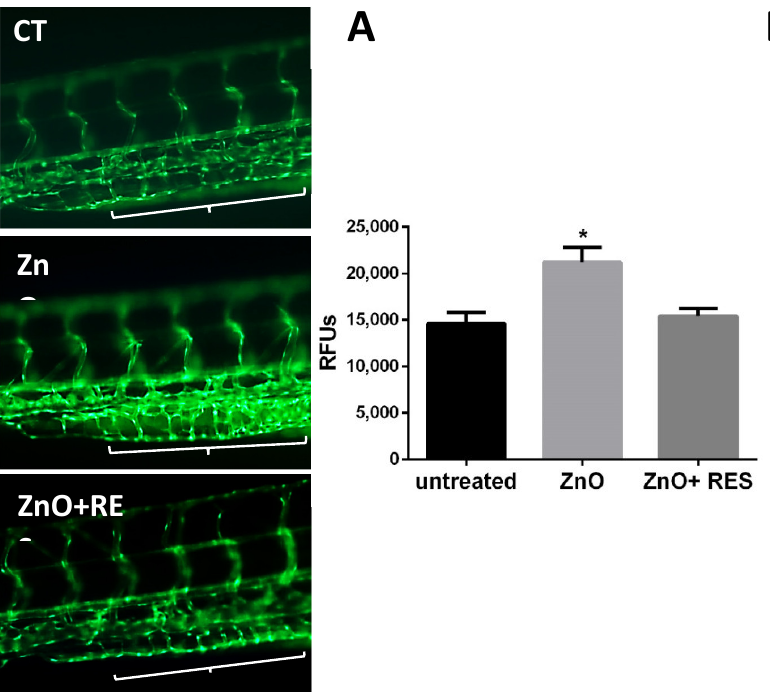
Figure 10. Resveratrol decreases the thickness of the blood vessel in ZnO NP-treated embryos. ( A ) Vessel of caudal vein plexus region of 96-hpf Fli1 embryos treated with 3 mg/L ZnO NP (ZnO) showed a significant increase in green fluorescence intensity (Thickening) compare to the untreated group (CT). Treatment of 5 μM resveratrol resulted in the prevention of NP-induced GFP signal increment (ZnO + RES). Regions of interest are marked by a white bracket. ( B ) Quantification of vessel thickness intensity was performed using ImageJ (v1.44 public domain software http://rsbweb.nih.gov/ij/) in 96-hpf embryos. RES, resveratrol. Values are shown as mean ± SD, n = 20. *, significantly different from the untreated. Magnification 20×.